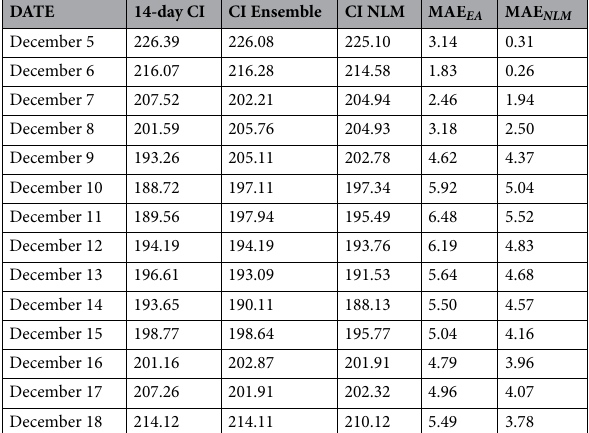
Table 11. 14-day CI accuracy prediction for ensemble approach (EA) and NLM methog (NLM). Training from July 20, 2020 to December 4, 2020, Prediction from December, 5 to December, 18.